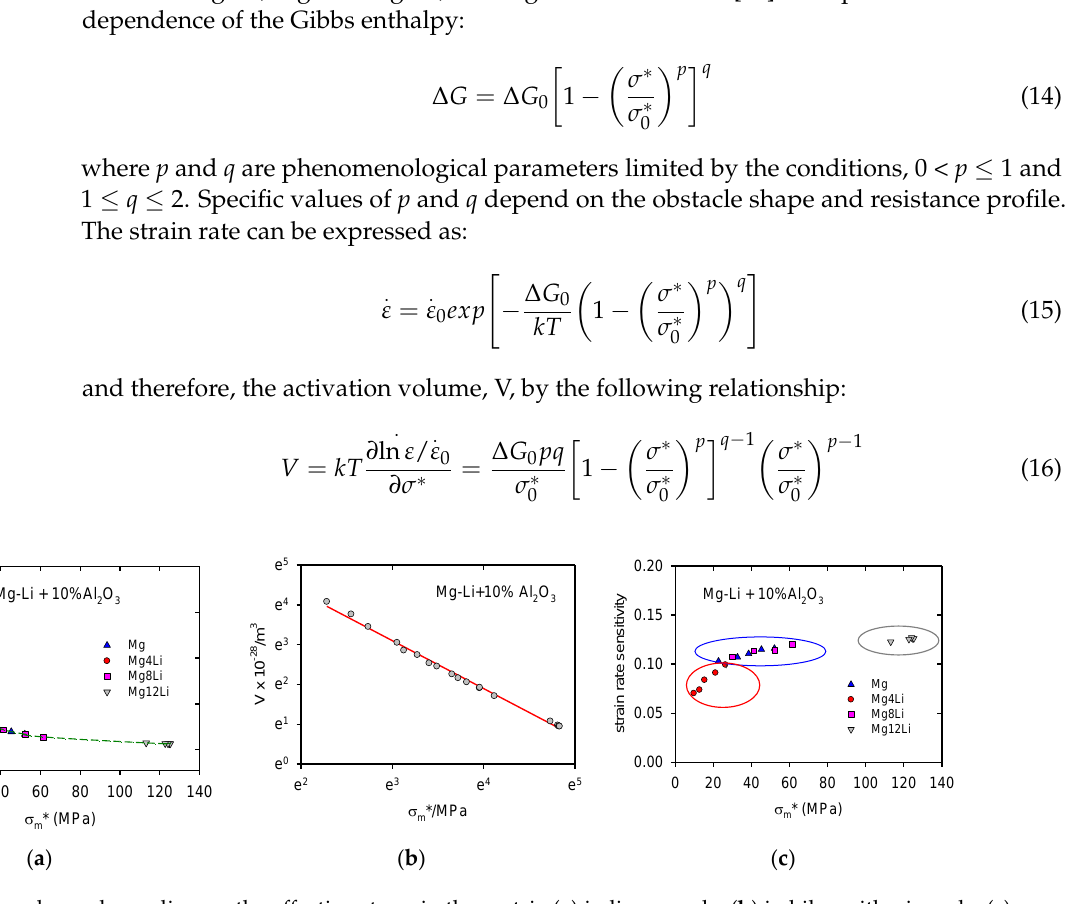
Figure 6. Activation volume depending on the effective stress in the matrix ( a ) in linear scale, ( b ) in bilogarithmic scale, ( c ) strain rate sensitivity depending on the effective stress in the matrix. Values estimated for all materials.